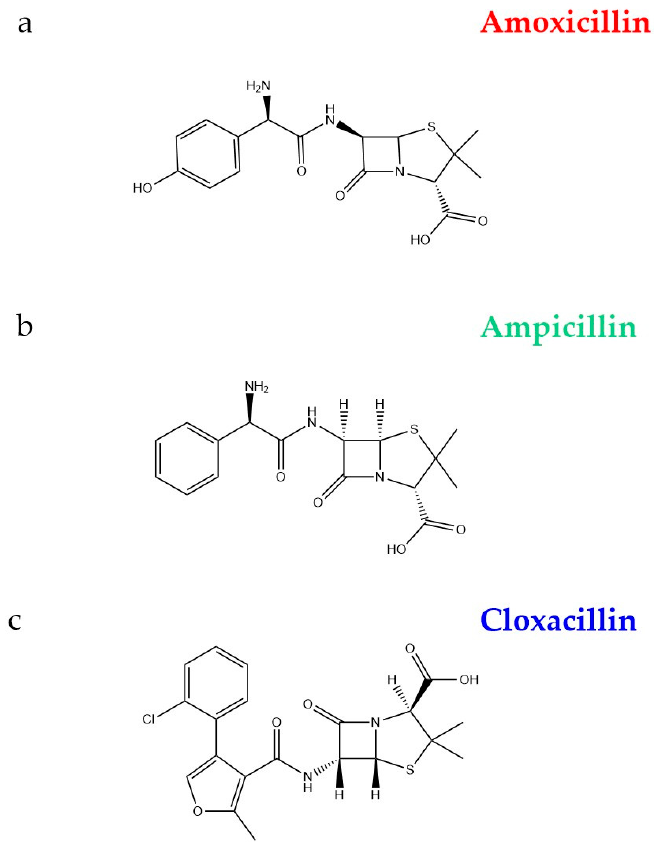
Figure 4. Molecular structure of some antibiotics ( a ) Amoxicillin; ( b ) Ampicillin; ( c ) Cloxacillin. Different TiO 2 nanomaterials may have different adsorption capacities towards different